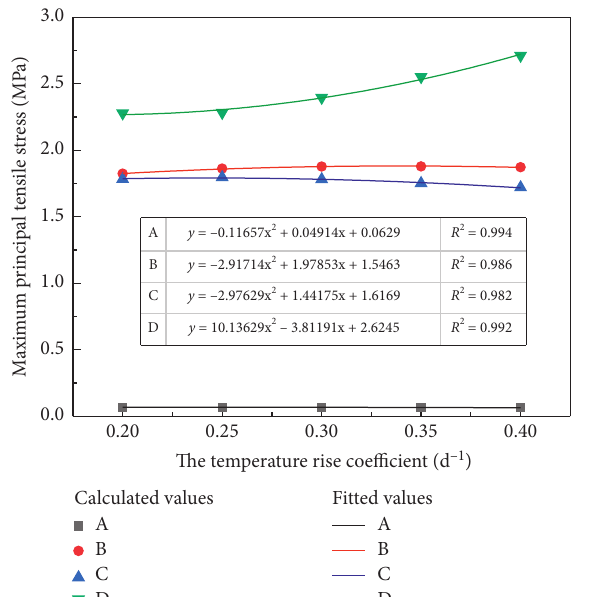
Figure 11: The calculated and fitted maximum principal tensile stress at each point with a different thermal temperature rise